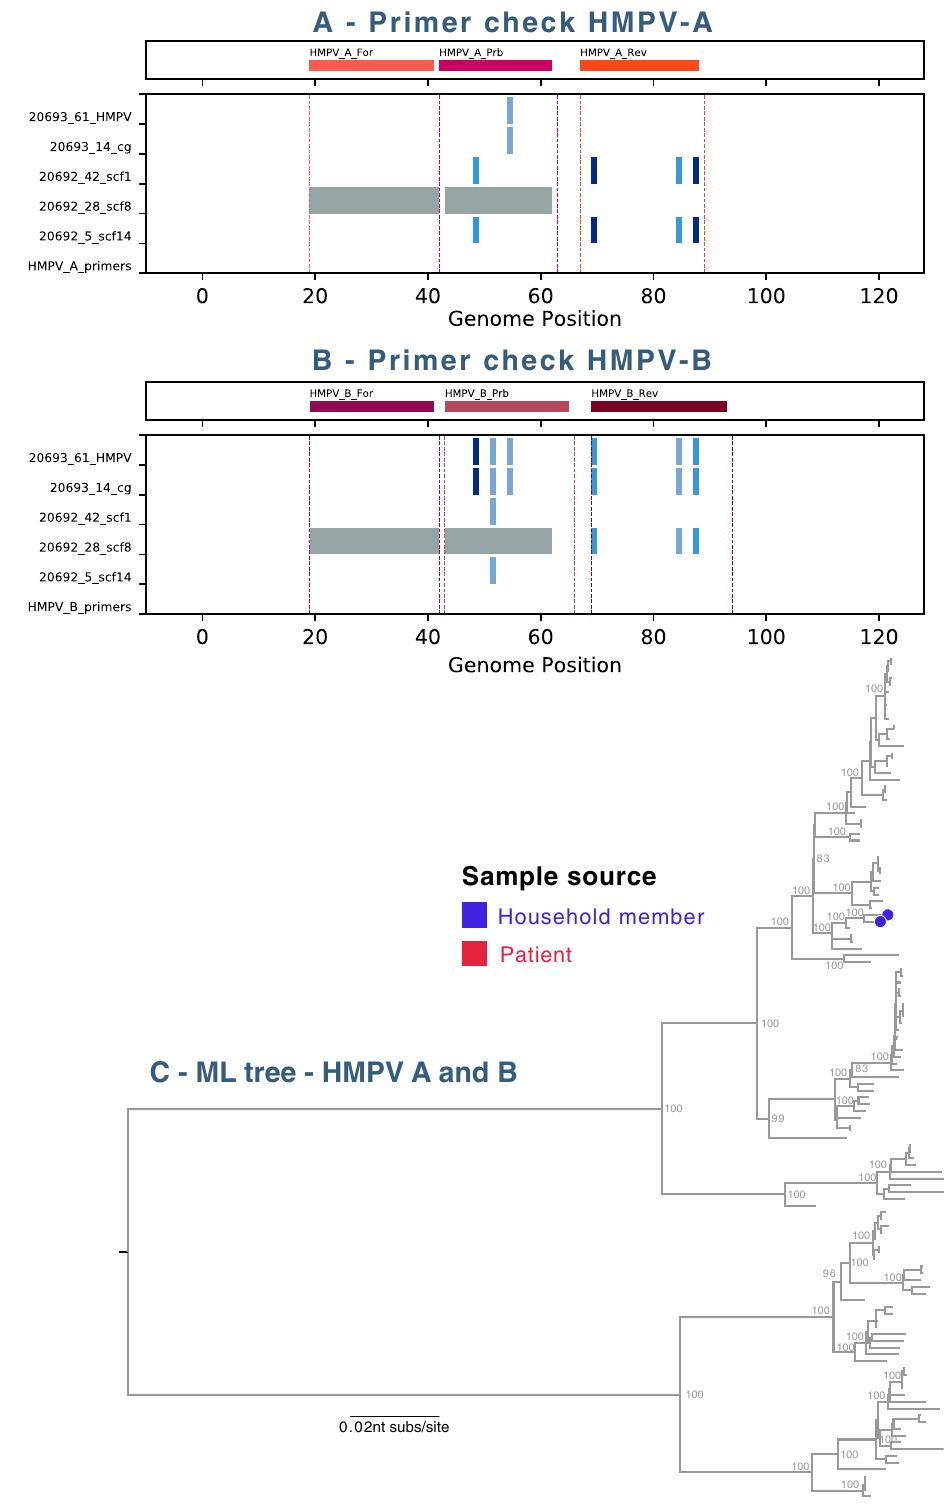
Figure 1. Human metapneumovirus (HMPV) identified in the study. ( A ) The diagnostic primers and probe target sites in the Kilifi HMPV genotype A genomes and contigs were examined. All viral contigs from each virus family or type were aligned using MAFFT 25 , and the alignment was trimmed to a 100–200 nt region surrounding the primer and probe target sites. Nucleotide differences between the expected primer and probe target sites and the actual contig sequences were identified and plotted in shades of blue and gaps in contig sequences were indicated in grey. ( B ) As in ( A ) but for HMPV genotype B. ( C ) Maximum-likelihood (ML) phylogenetic tree of HMPV genomes. Local strains on the phylogenetic tree were indicated by circles coloured in blue indicating household member and in red indicating KCH patients. The tree was mid-point rooted for clarity and horizontal branch lengths were drawn to the scale of nucleotide substitutions per site. The tree comparing local HMPV genomes to global genomes suggested that the local HMPV belonged to genotype A2 and